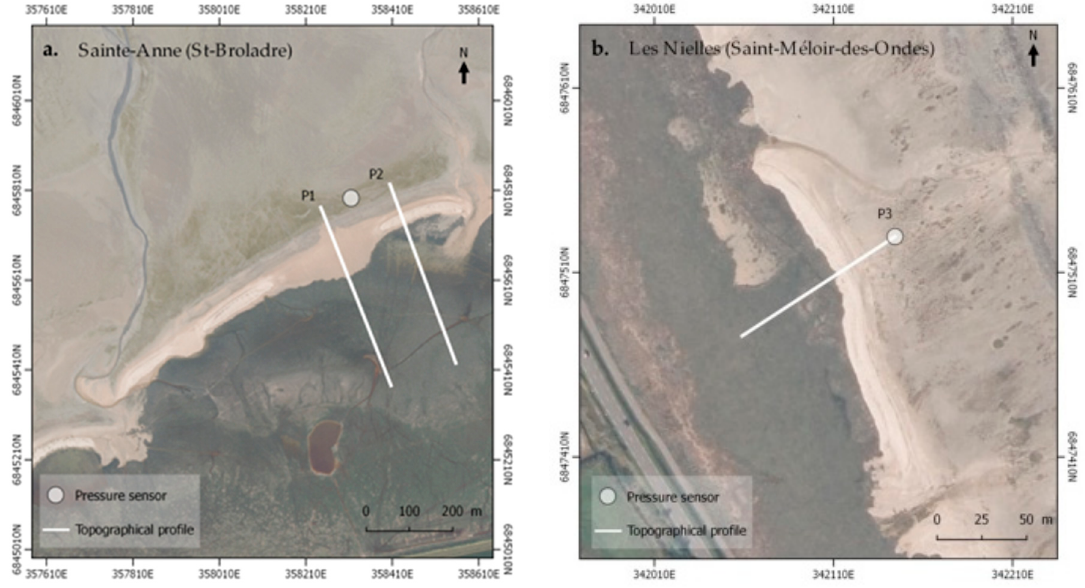
Figure 3. Pressure sensors and topographic profiles localization map: ( a ) Sainte-Anne site, ( b ) Les Nielles site.